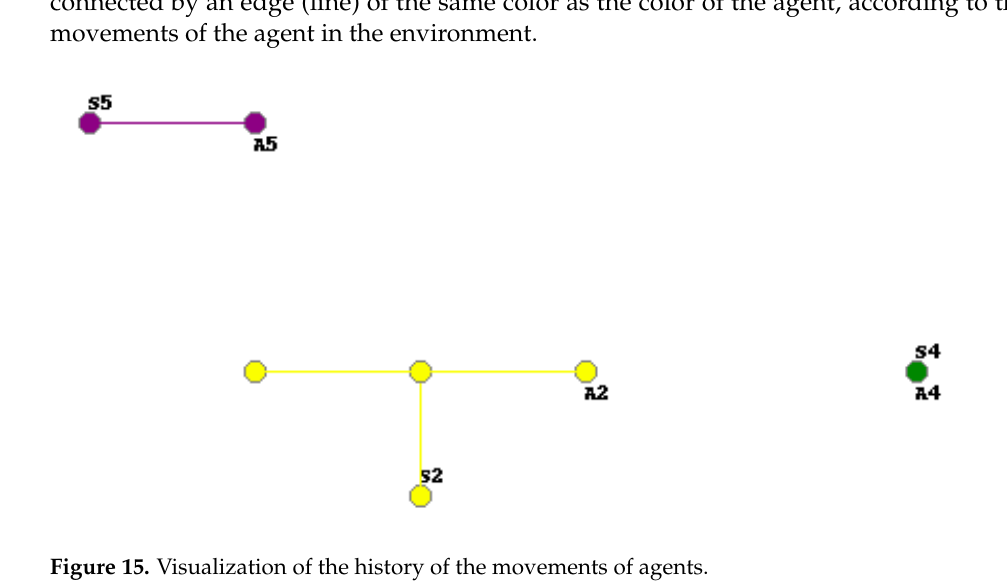
Figure 15. Visualization of the history of the movements of